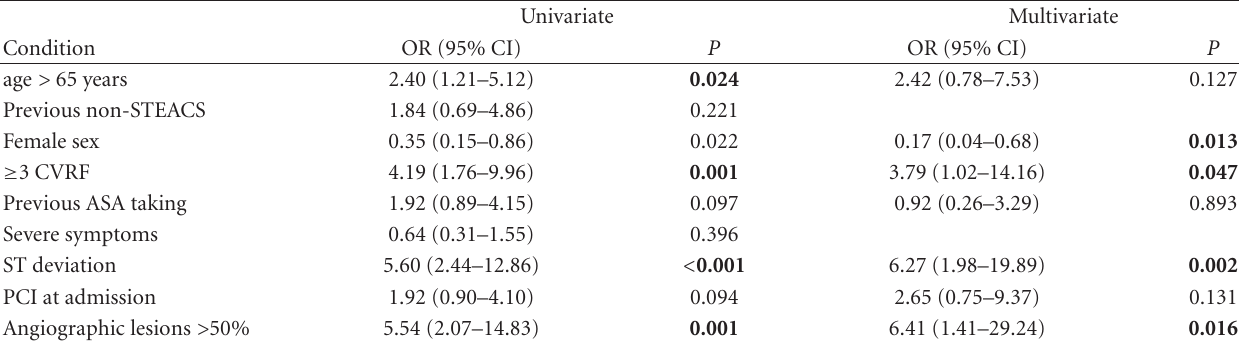
Table 3: Association of elevated hsTnT levels with clinical features. Logistic regression analyses. Cuto ff point for hsTnT = 0.013 ng/mL.